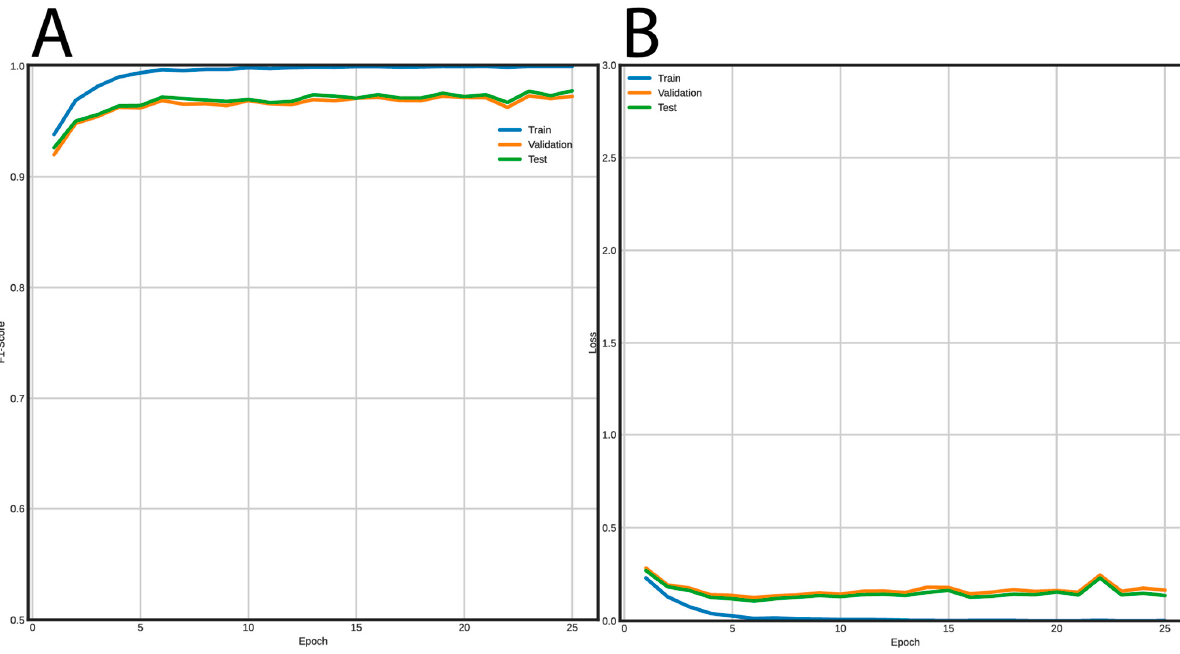
Figure 6. Learning curves using the CNN architecture to classify LTR retrotransposons into lineages. ( A ) F1-Score vs epochs, and ( B ) loss vs epochs.